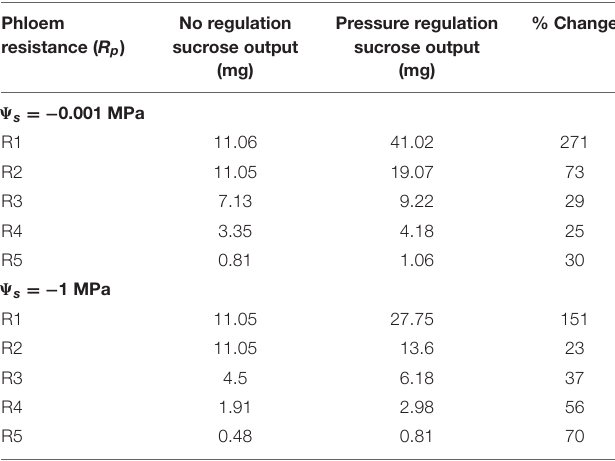
TABLE 4 | Comparing the maximum sucrose output of the unregulated phloem loading scenario ( Figure 5 ), to the pressure regulated loading scenario (data found in Figure 7